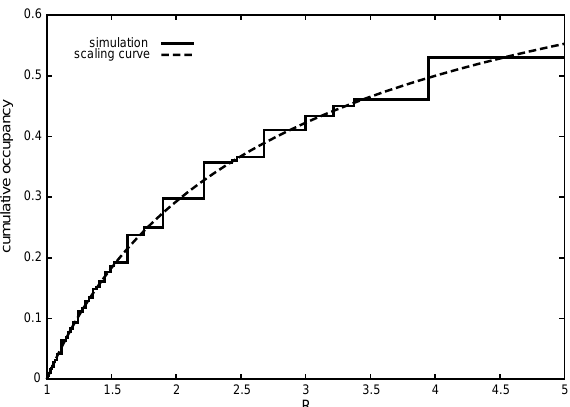
simulation scaling curve